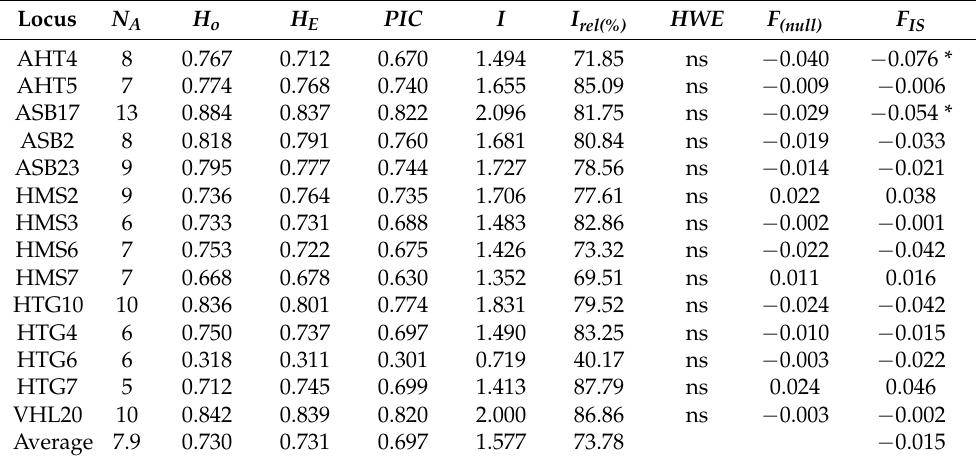
Table 3. Parameters of the genetic diversity for each of the 14 microsatellite markers in stallions of the Croatia Posavina horse ( n =